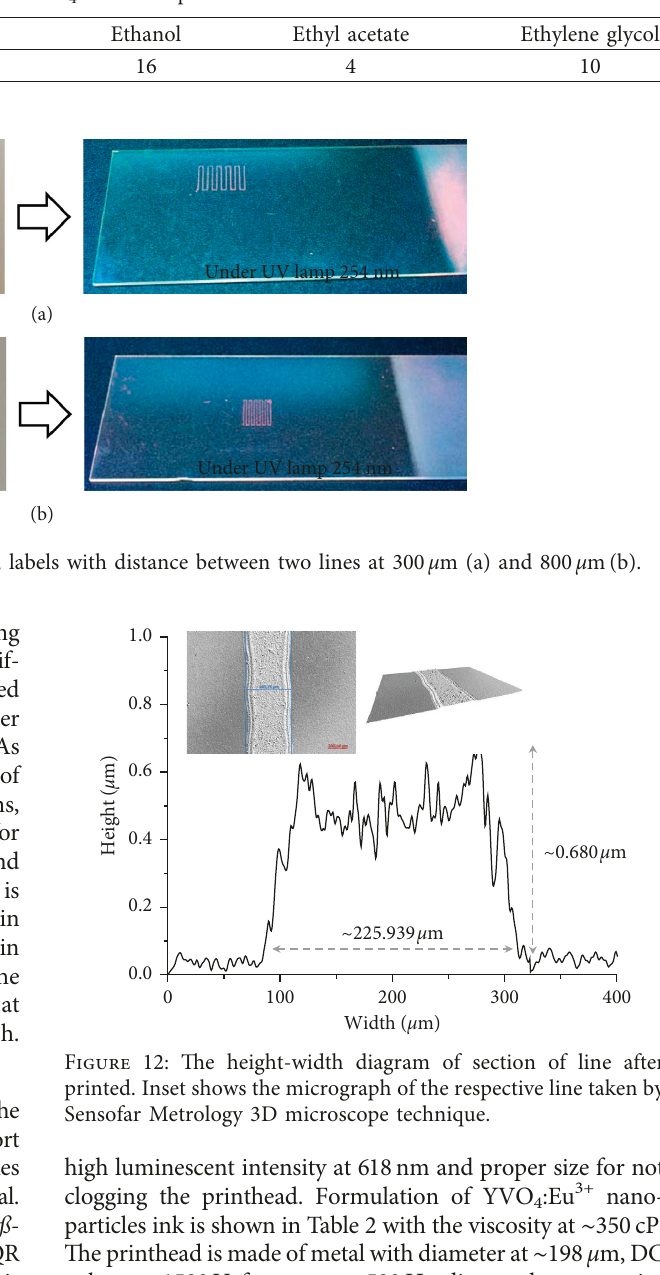
3+ nanoparticles ink. 4 :Eu